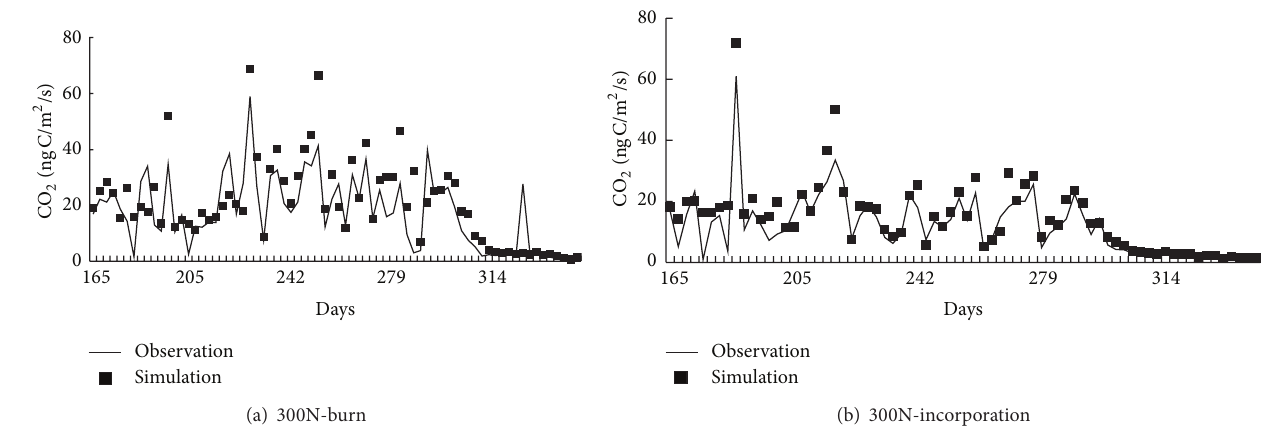
Figure 2: Comparison of observed and simulated CO 2 flux during crop growth period. Table 4: Correlation coefficients between CO